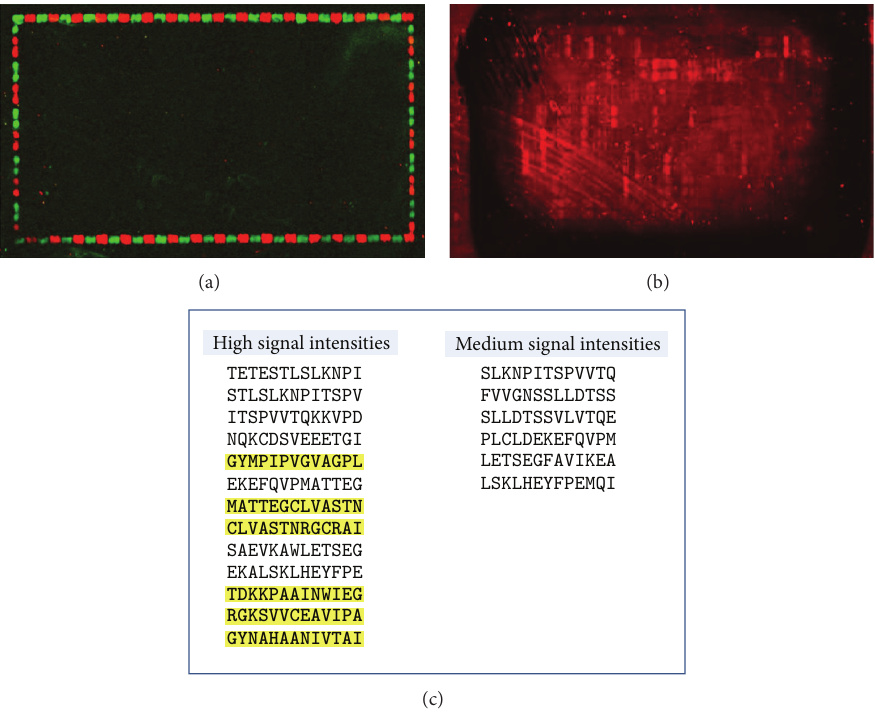
Figure 5: Epitope mapping of anti-HMGCR antibodies. DyLight680 showed no background interaction with the secondary antibody (a); incubation with anti-HMGCR positive serum revealed a number of reactive peptides (b). Epitopes identified using solid phase array are shown in (c). Sequences in yellow were selected for soluble peptide synthesis based on reactivity and surface